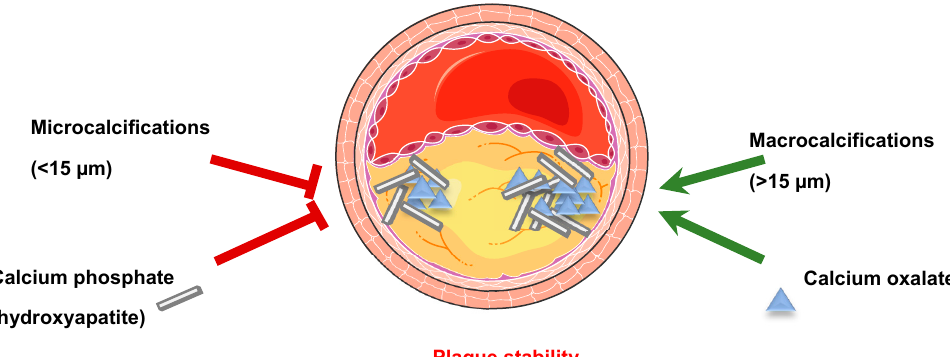
Figure 2. Vascular calcification affects plaque stability. Microcalcifications (0.5–15 µ m) and spotty calcifications are positively associated with plaque rupture. Plaques with macrocalcifications (>15 µ m) are more often asymptomatic, suggesting that large calcifications are beneficial for plaque stability. The nature of calcium minerals composing calcifications also plays a role in plaque stability. Calcifications composed of hydroxyapatite (calcium phosphate) crystals are associated with plaque instability, while calcium oxalate containing calcifications, present in approximately 30% of the human atherosclerotic plaques, are mainly associated with plaque stability.